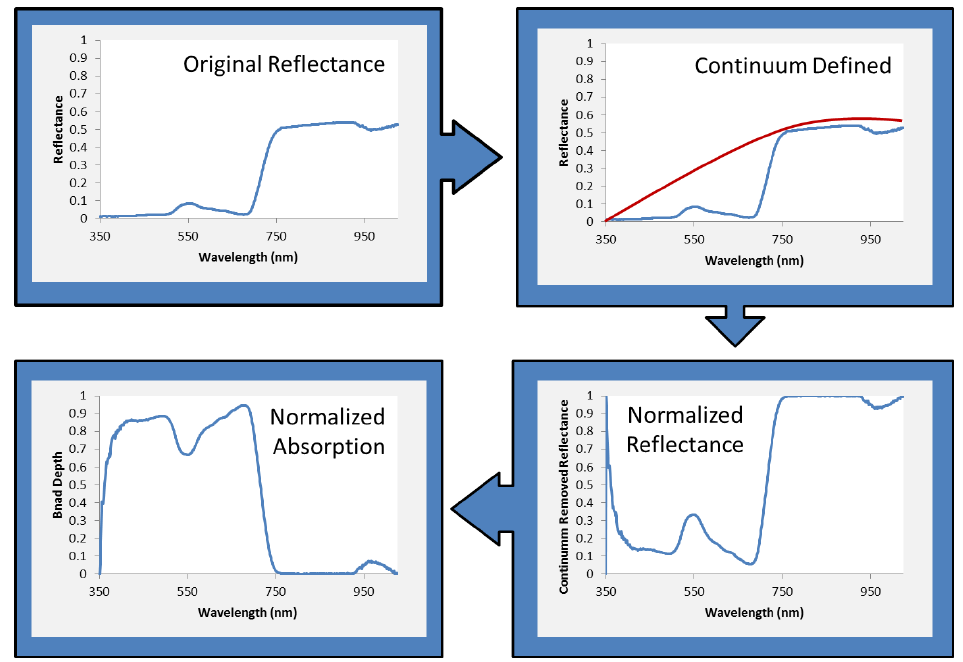
Calculating band depth (normalized absorption) from original reflectance using continuum